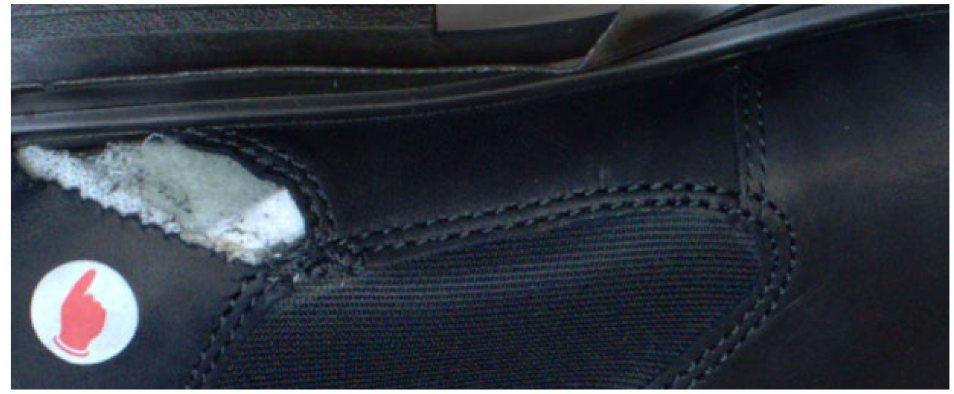
Figure 4. Object for testing of lighting.